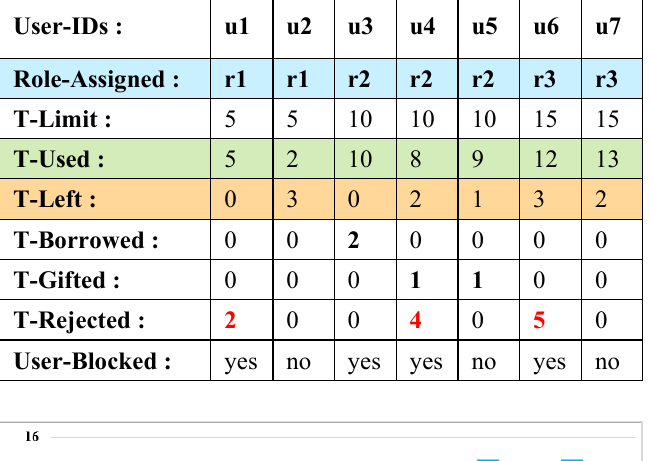
Table 4. Simulation Status Scenario 2